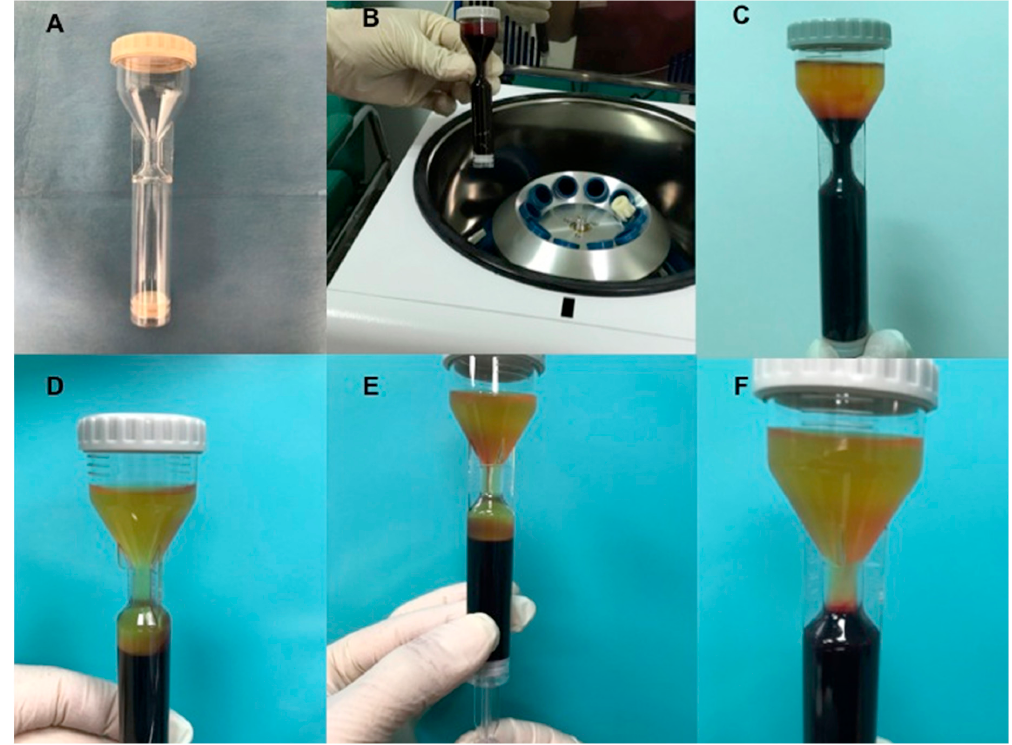
Figure 4. i-Stem platelet rich plasma (PRP) procedure. ( A ) Kit i-Stem; ( B ) The blood collected in i-Stem Kit underwent at centrifugation; ( C ) The PRP and PPP suspension obtained by the system after the first centrifugation; ( D ) The PRP and PPP after the second centrifugation.; ( E ) selection of PRP; ( F ) PRP concentration in the middle side of